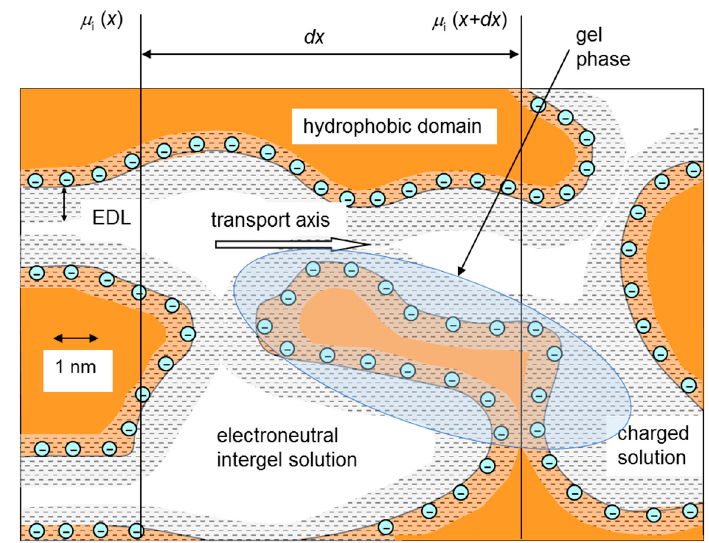
Figure 3. Schematic representation of the IEM structure with its main elements: fixed ions (shown as circles with “ − ”), EDL formed at the internal interfaces and electroneutral solution in the centre zone of inter-gel spaces. The gel phase includes the polymer matrix bearing the fixed ions and the EDL. Adapted with permission from [46], Elsevier, 2008.